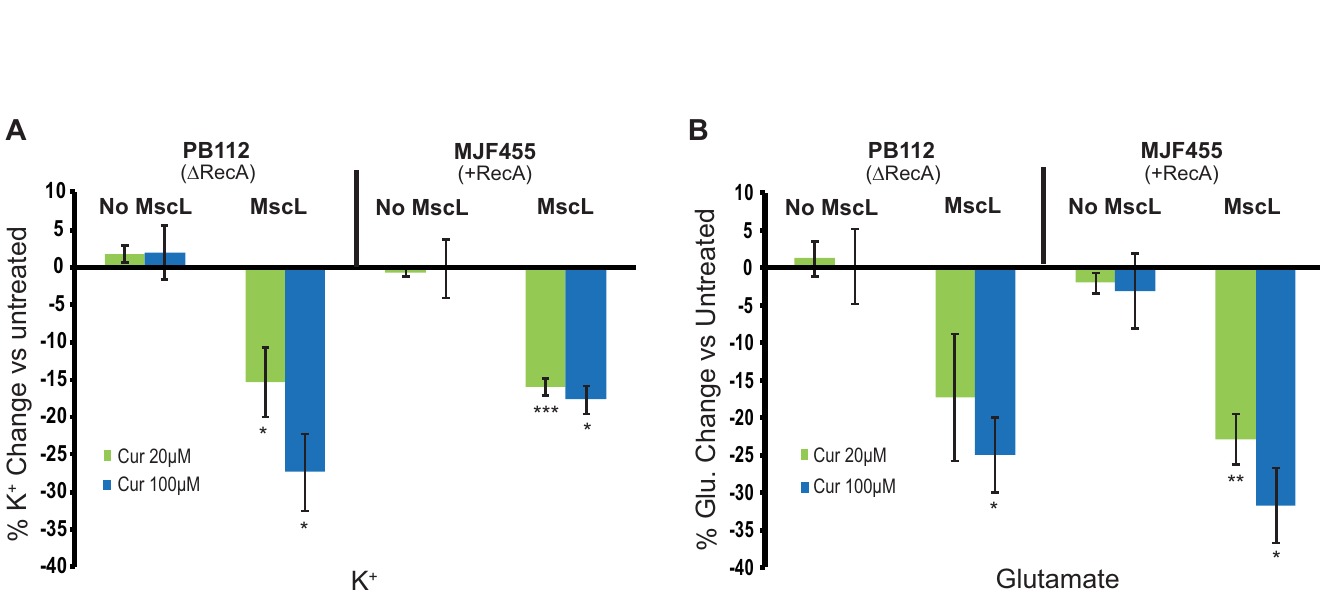
Fig 5. Curcumin induces a MscL-dependent reduction in bacterial K + and glutamate steady state. Shown are the E . coli Stains PB112 ( Δ RecA, Δ MscL, Δ MscS) and MJF455 ( Δ MscL, Δ MscS) carrying vector only (No MscL) or expressing MscL (MscL), treated with curcumin at 20 μ M (green) or 100 μ M (blue). A) The reduction of potassium was measured after overnight treatment of curcumin (as indicated) and expressed as the percentage change of K + remaining compared to untreated. B) The reduction of glutamate was similarly measured as the percent change vs Untreated. n = 3. Statistics reflect a comparison of MscL-expressing versus “no MscL” strains � P < 0.05, �� P < 0.005, ��� P < 0.0005 as indicated, 2-tailed, homoscedastic